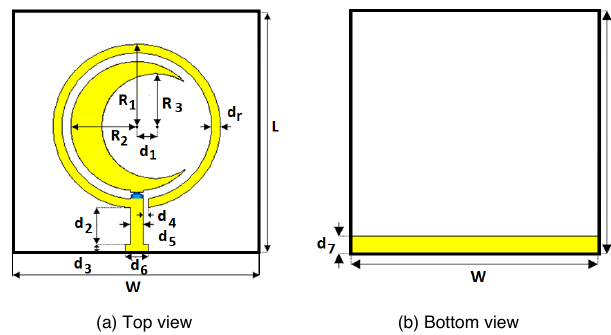
FIGURE 1. The geometry of the proposed-single antenna TABLE I. The dimensions of the proposed-single antenna Parameter FIGURE 2. Equivalent circuit of Beam Lead PIN diode